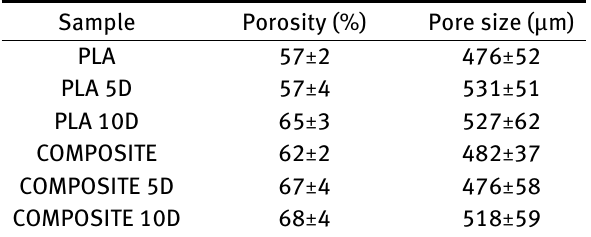
Table 1: Porosity and pore size values of the 3D printed scaffolds before and after